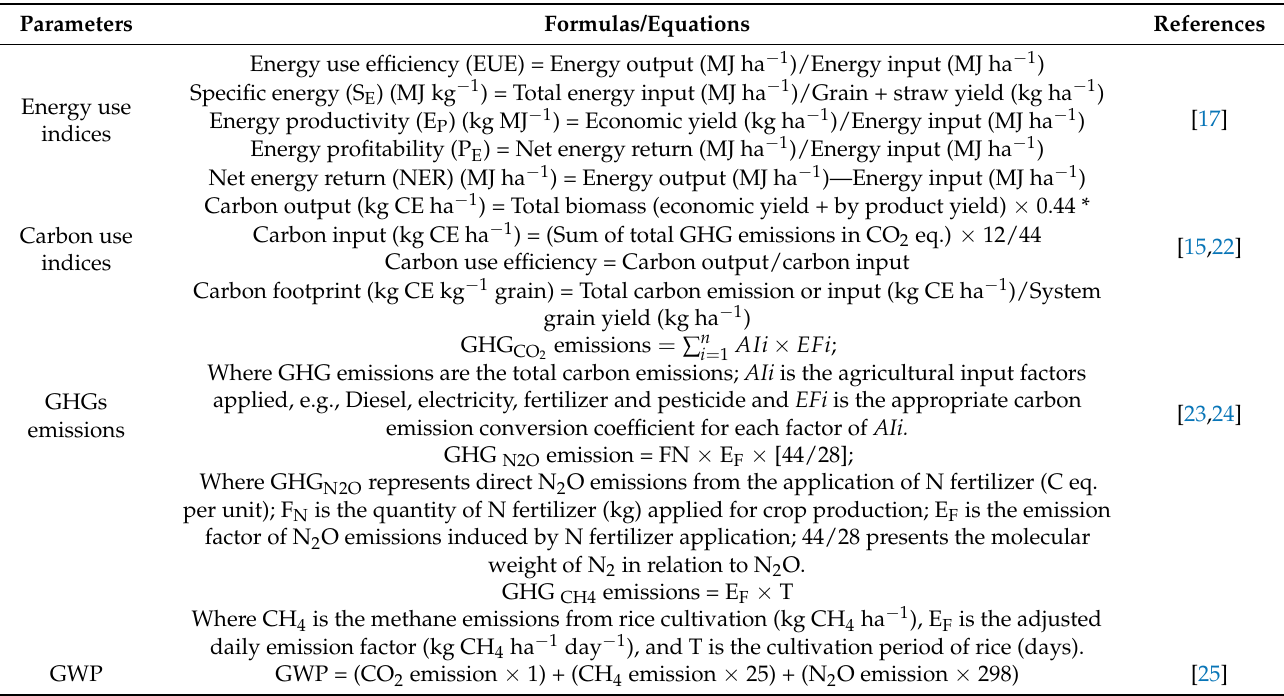
Table 3. Energy equivalents of inputs and outputs in agricultural